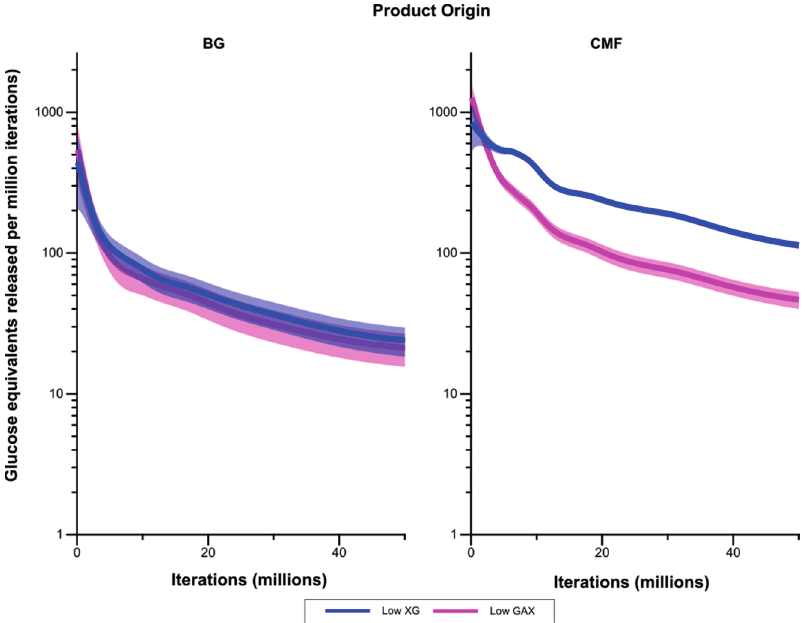
Figure 9. Rates of liberation of glucose equivalents from the degradation of (1,3;1,4)- β -glucans (BG) and CMF in the Low GAX and Low XG walls. The shaded region represents a 95% Least Significant Interval so that the two curves are significantly different at the 5% level where the bands do not overlap. The solid line in the middle indicates the mean